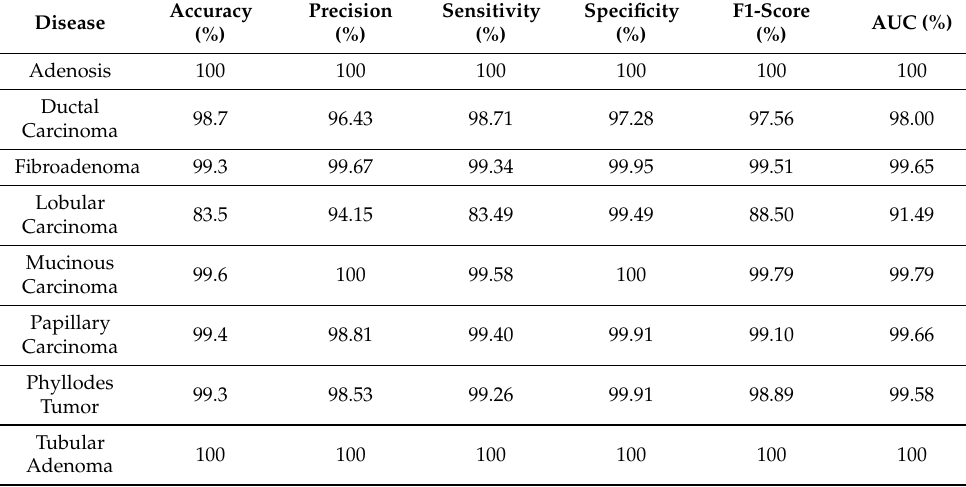
Table 10. Performance of ensemble model for each of the eight